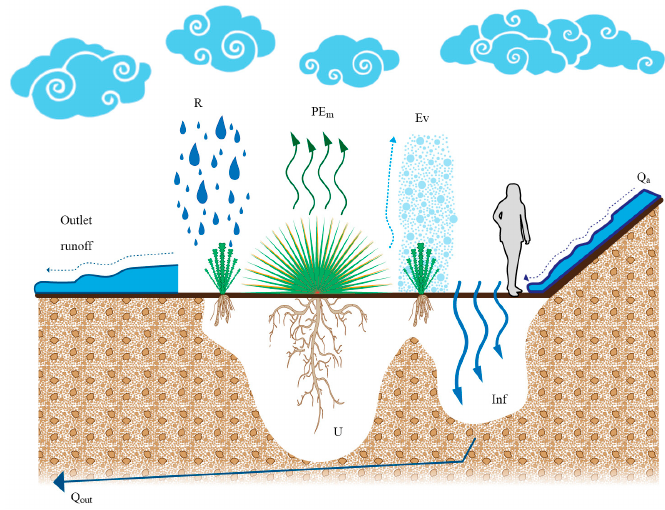
Figure 6. Water balance scheme.